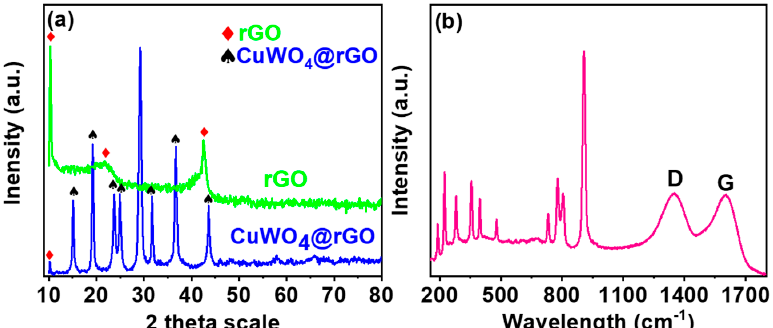
Figure 3. ( a ) X-ray powder diffraction (XRD) pattern recorded for CuWO 4 @rGO hybrids in reference